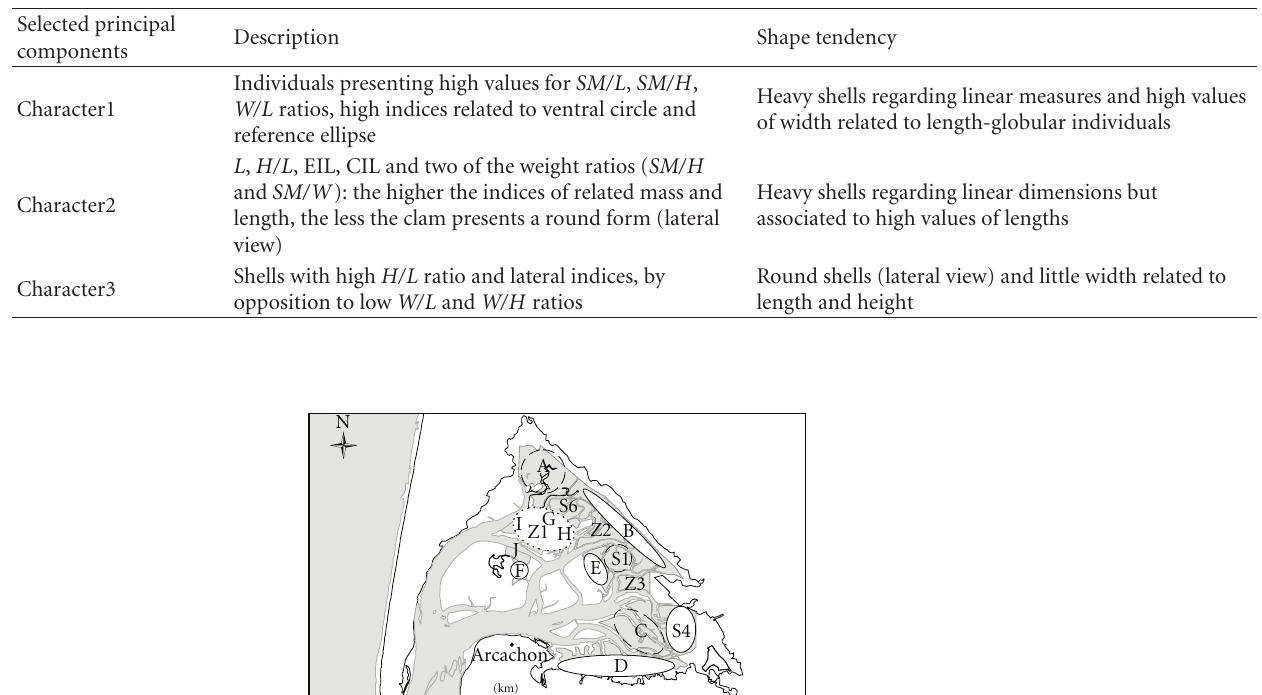
Table 2: NPCA synthetic descriptors.